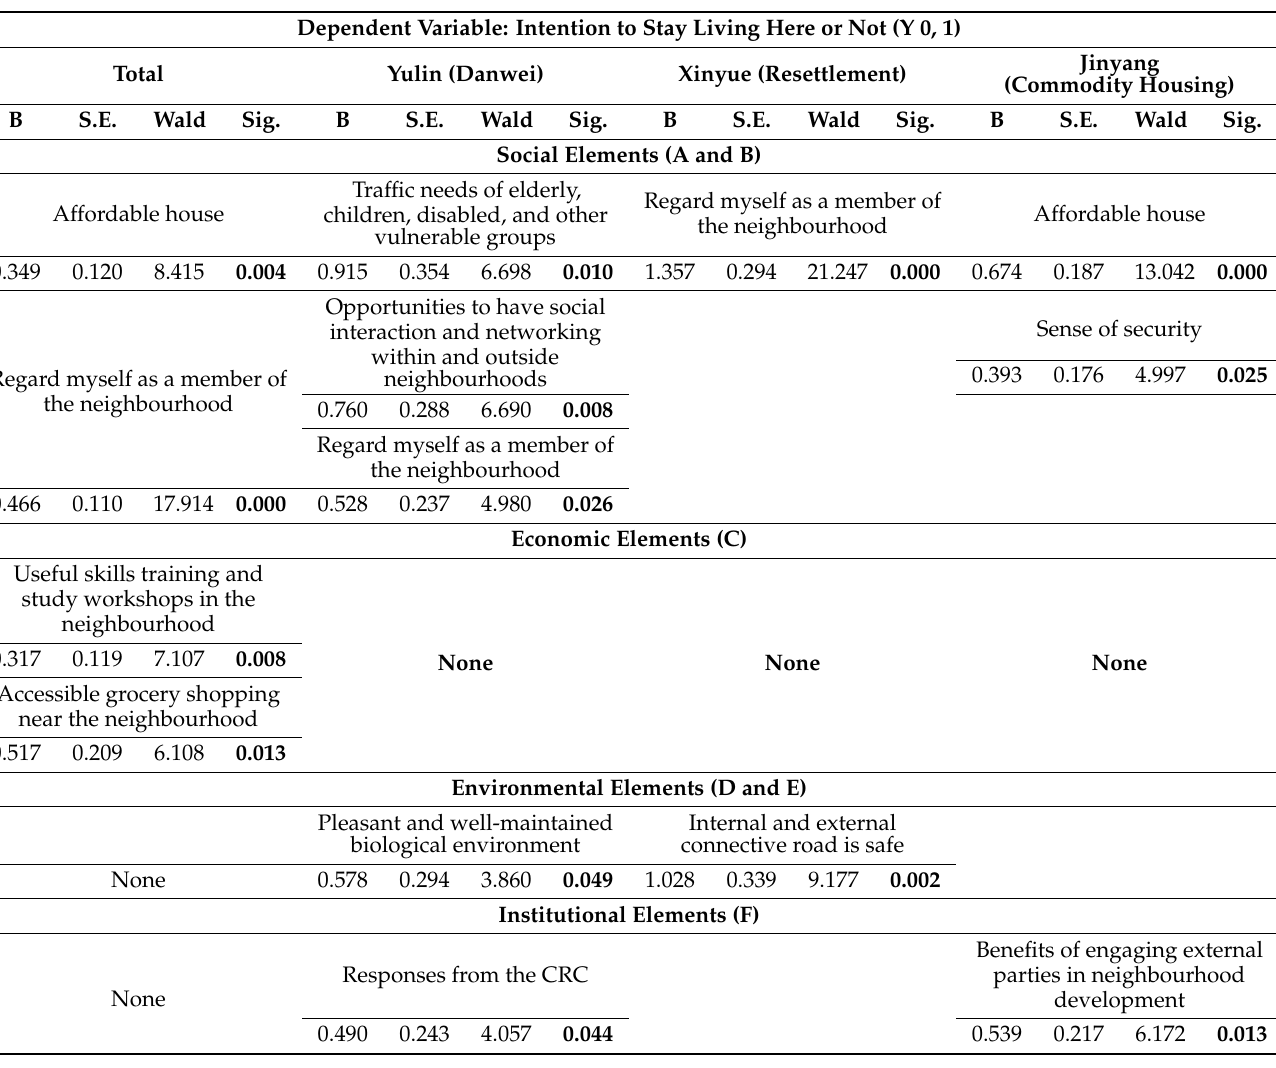
Table 5. Model 2 (including sustainability factors and moving